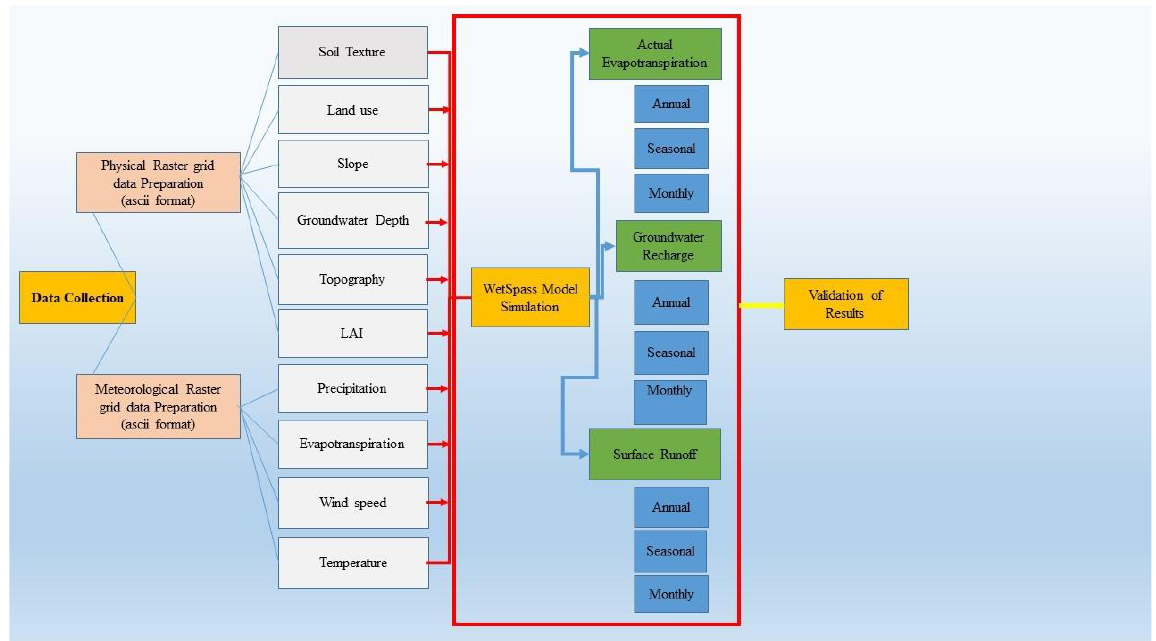
Figure 2. Scheme of WetSpass-M